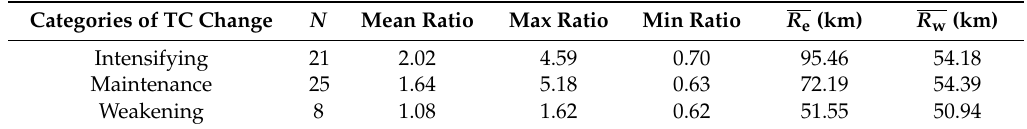
Table 6. Statistics of the radius of the maximum wind of TCs and the size of warm ocean eddies: R e is the average value of the equivalent radius of warm ocean eddies and R w is the average value of the radius of maximum wind of TCs that interact with warm ocean eddies.